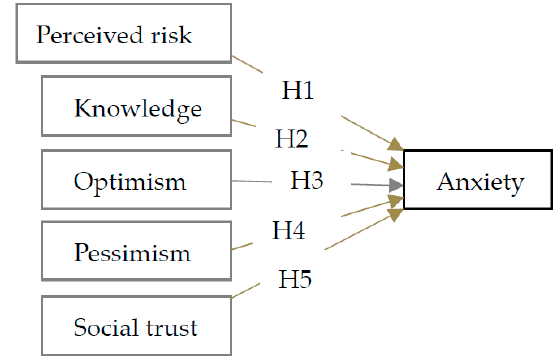
Figure 1. Schematic illustration of the research model 1.